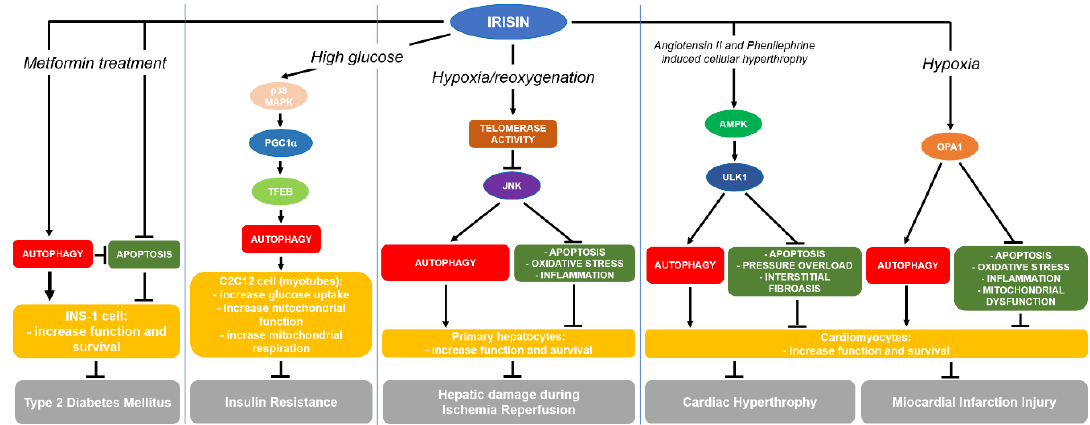
Figure 4. Effect of irisin on autophagy in multiple cells. AMPK: AMP activated protein kinase; INS-1 cell: insulinoma-1 cell; OPA1: dynamin-like GTPase optic atrophy 1; PGC1 peroxisome proliferator-activated receptor gamma coactivator 1- α ; p38 MAPK: p38 mitogen-activated protein kinase; TFEB: transcription factor EB; JNK: c-Jun N-terminal kinase; ULK1: Unc-51 like autophagy activating kinase 1.